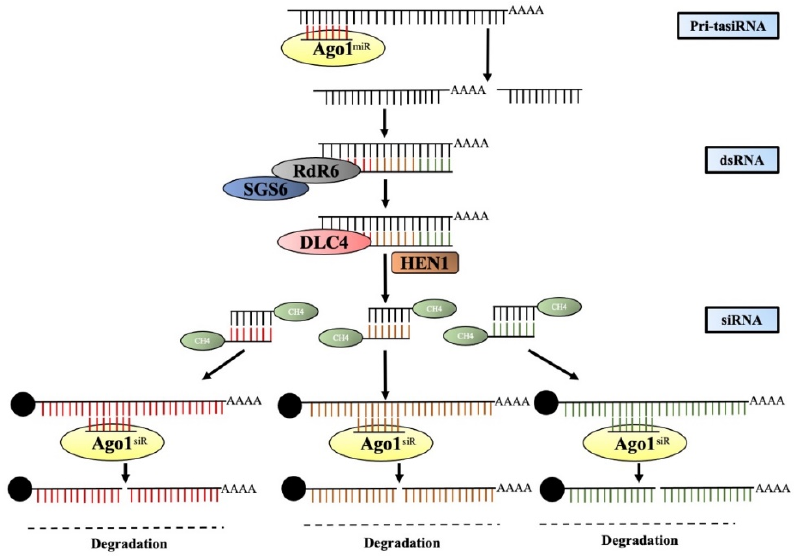
Figure 4. The genomic TAS locus produces the pri-tasi transcripts. They are cut by miRNA by AGO1 and transformed into a double-strand by SGS3 and RDR6 jointly. Moreover, 21-nt-diced siRNA is produced and is methylated by HEN1. Finally, the target transcript is degraded by the 21-nt siRNA in a sequence-specific